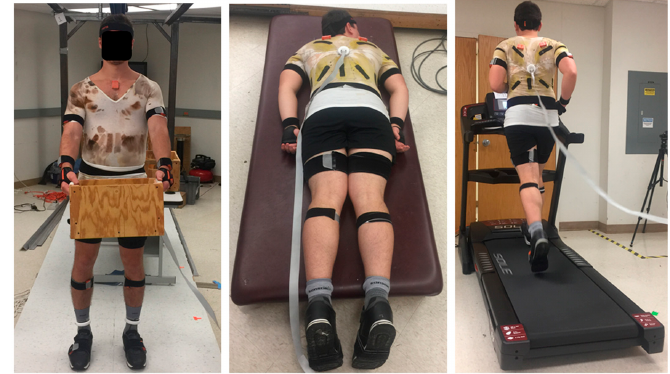
Figure 1. Illustrations of a participant wearing two smart textile systems (STSs) (an SUS and smart socks) and a full-body inertial measurement unit (IMU) system during a sample of activities: carrying a box ( left ), laying down ( middle ), and running on a treadmill ( right ).